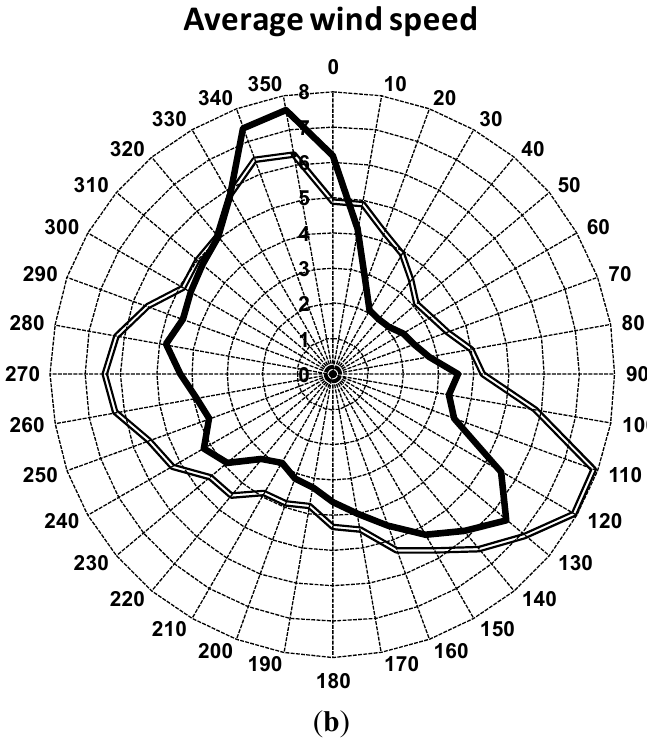
Figure 2. ( a ) Frequencies of wind (in %) with direction for the period 2002–2012, stations A (unfilled black line) and B (solid black line); ( b ) Average wind speeds (in m·s − 1 ) with direction for the period 2002–2012, stations A (unfilled black line) and B (solid black